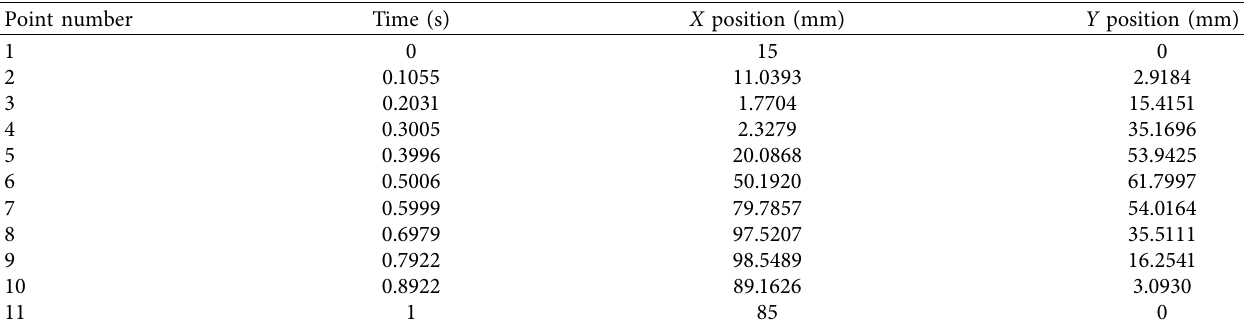
Table 8: Corresponding trajectory points obtained by GA.